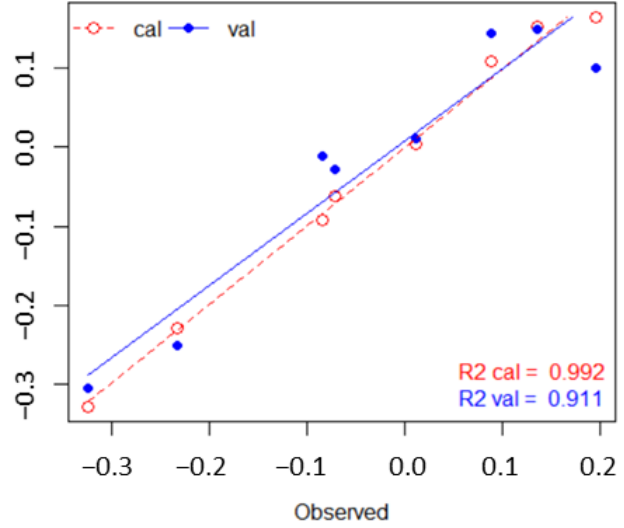
Figure 5. Matrix Results for Dimensions 1 and 2 from Multi-Dimensional Ordination. Both ( A , B ) show Isomap Distances for k = 7, Plots = 144, PFT = 8. ( A ) Numbered-rectangles represent composition of plots sampled in the field. More similar plot compositions are indicated by closer rectangles and more similar line coloring. For plots with the same or highly similar composition, only one rectangle is visible. ( B ) for the same sampled plots as ( A ), rectangles show the dominant PFT as centroids in multi-ordinate space.